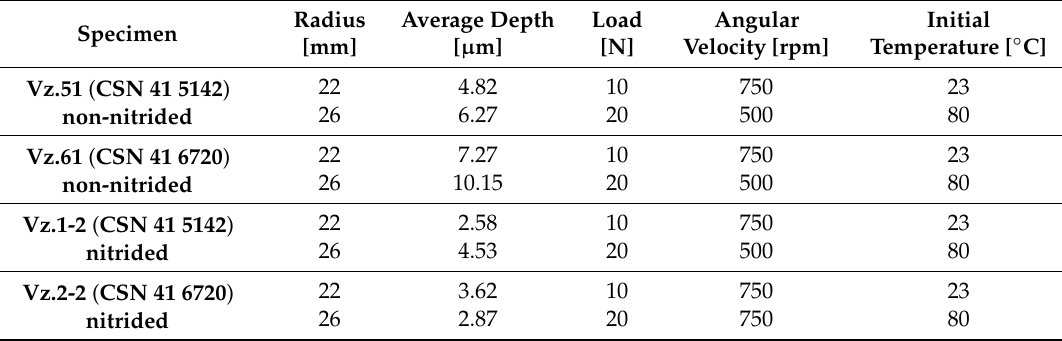
Table 5. Evaluation of wear .